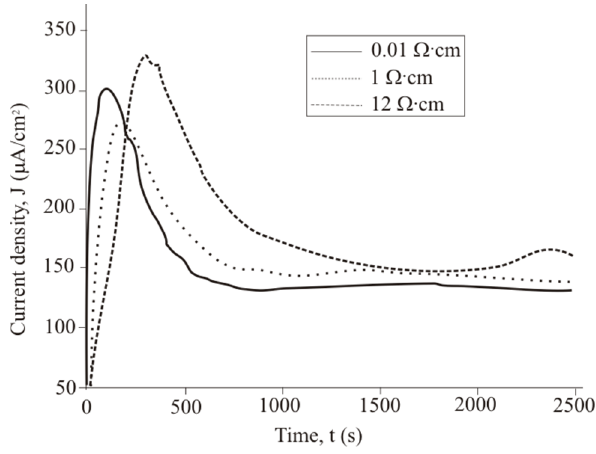
Figure 6. Current density measured under 460 lx illumination.